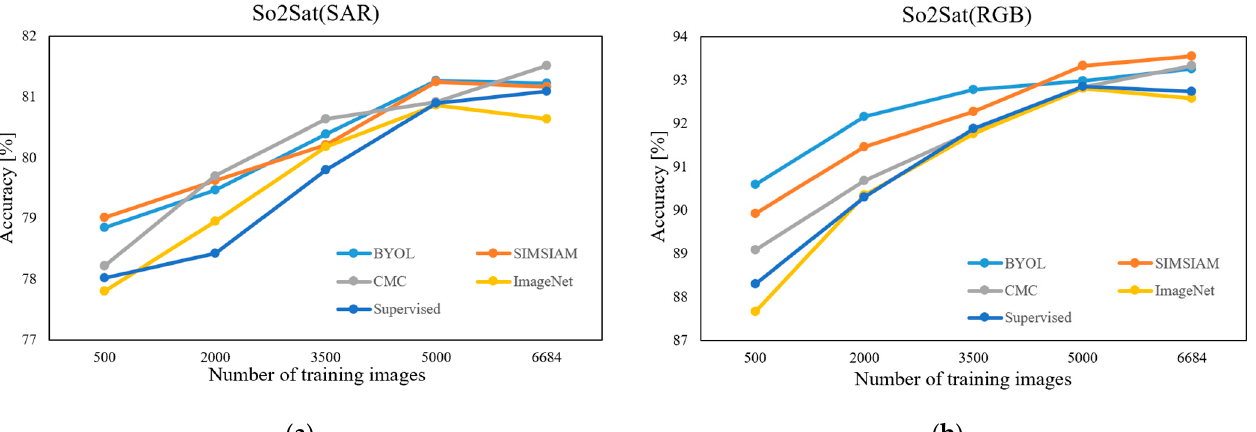
Figure 14. Overall accuracy achieved by different methods on test set versus the number of samples used for the training of the finetuning evaluation. ( a ) The classification accuracy of SAR images in So2Sat dataset; ( b ) The classification accuracy of RGB images in So2Sat dataset.